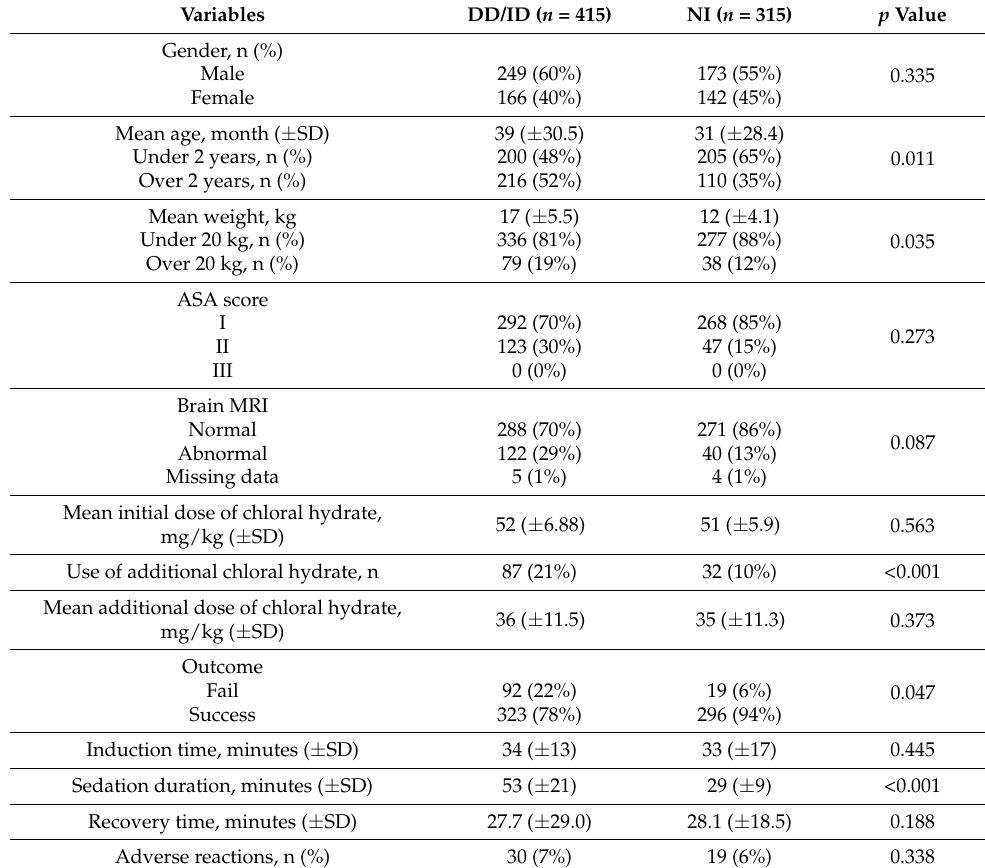
Table 1. Demographics of sedation in children with developmental delay/intellectual disability and normal